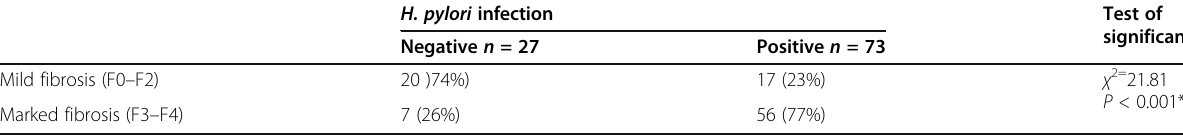
Table 6 Liver fibrosis score among HP positive versus HP negative subjects in MET S with NAFLD group H. pylori infection